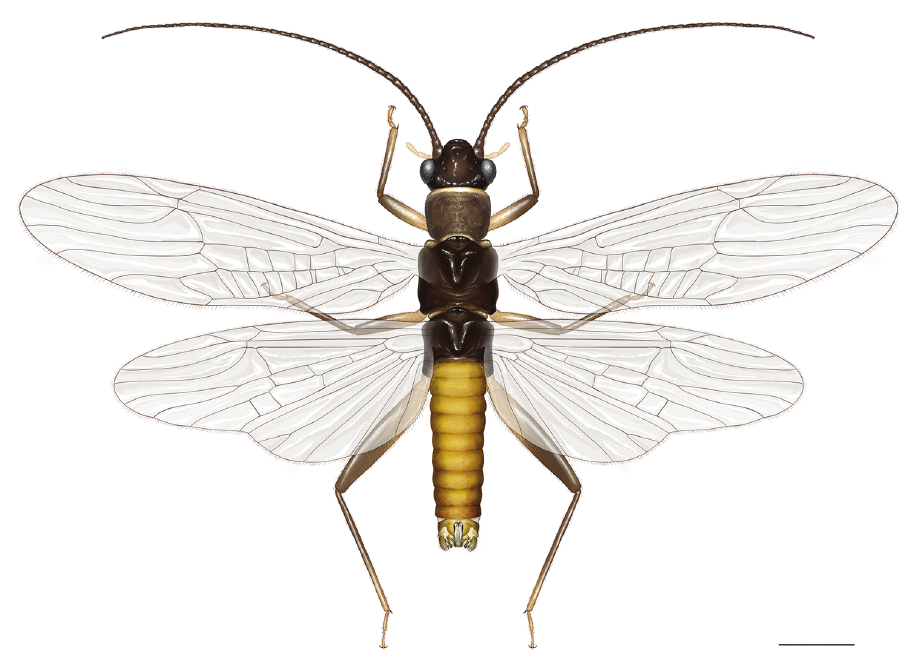
Figure 16. Amphinemura dingoidea sp. n., habitus of male holotype adult. Scale bar: 1 mm. dian lobe long, curved and with 5 or 6 apical spines, outer lobe short and lacks spine. Female: subgenital plate strongly bilobed with dome-like median notch, paragenital plate with two branches, inner genitalia simple. Larva: general color light brown with specific, distinct dark brown dorsal pattern, setation